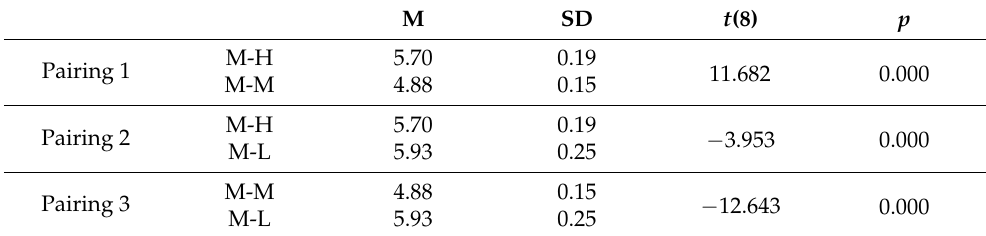
Table 4. Time distribution results table of medium pitch–height.